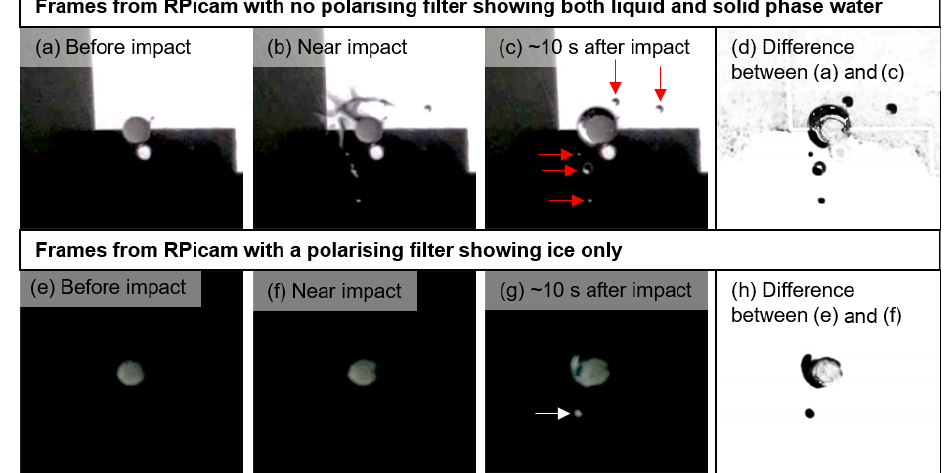
Figure 5. Selected frames from the impact of a supercooled water drop on an ice particle at − 4 ◦ C using the RPicam configuration. Frames (a) – (c) before, at and ∼ 10s after impact using the camera with no polarising filter. Red arrows in (c) indicate the number of secondary drops formed. Frame (d) shows the difference between (a) and (c) . Frames (e) – (g) before, at and ∼ 10s after impact using the camera with a polarising filter. The white arrow in (h) indicates the frozen secondary drop. Frame (h) shows the difference between (e) and (g)